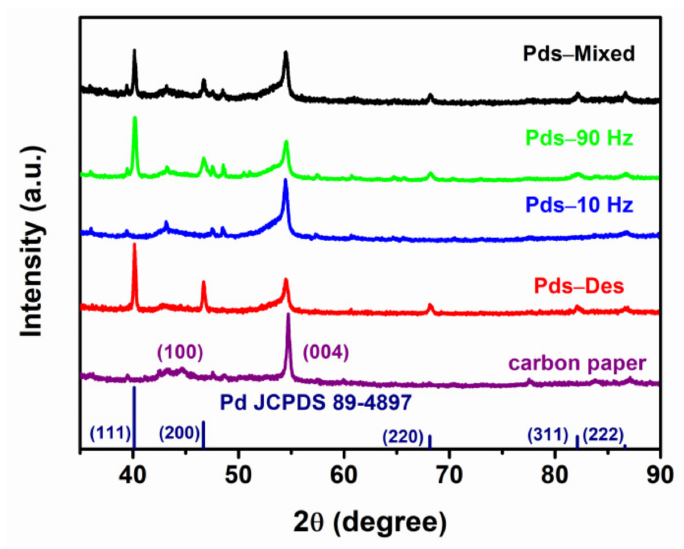
Figure 5. X-ray diffraction patterns (XRD) image of different samples including carbon paper, Pds–Des, Pds–10 Hz, Pds–90 Hz,